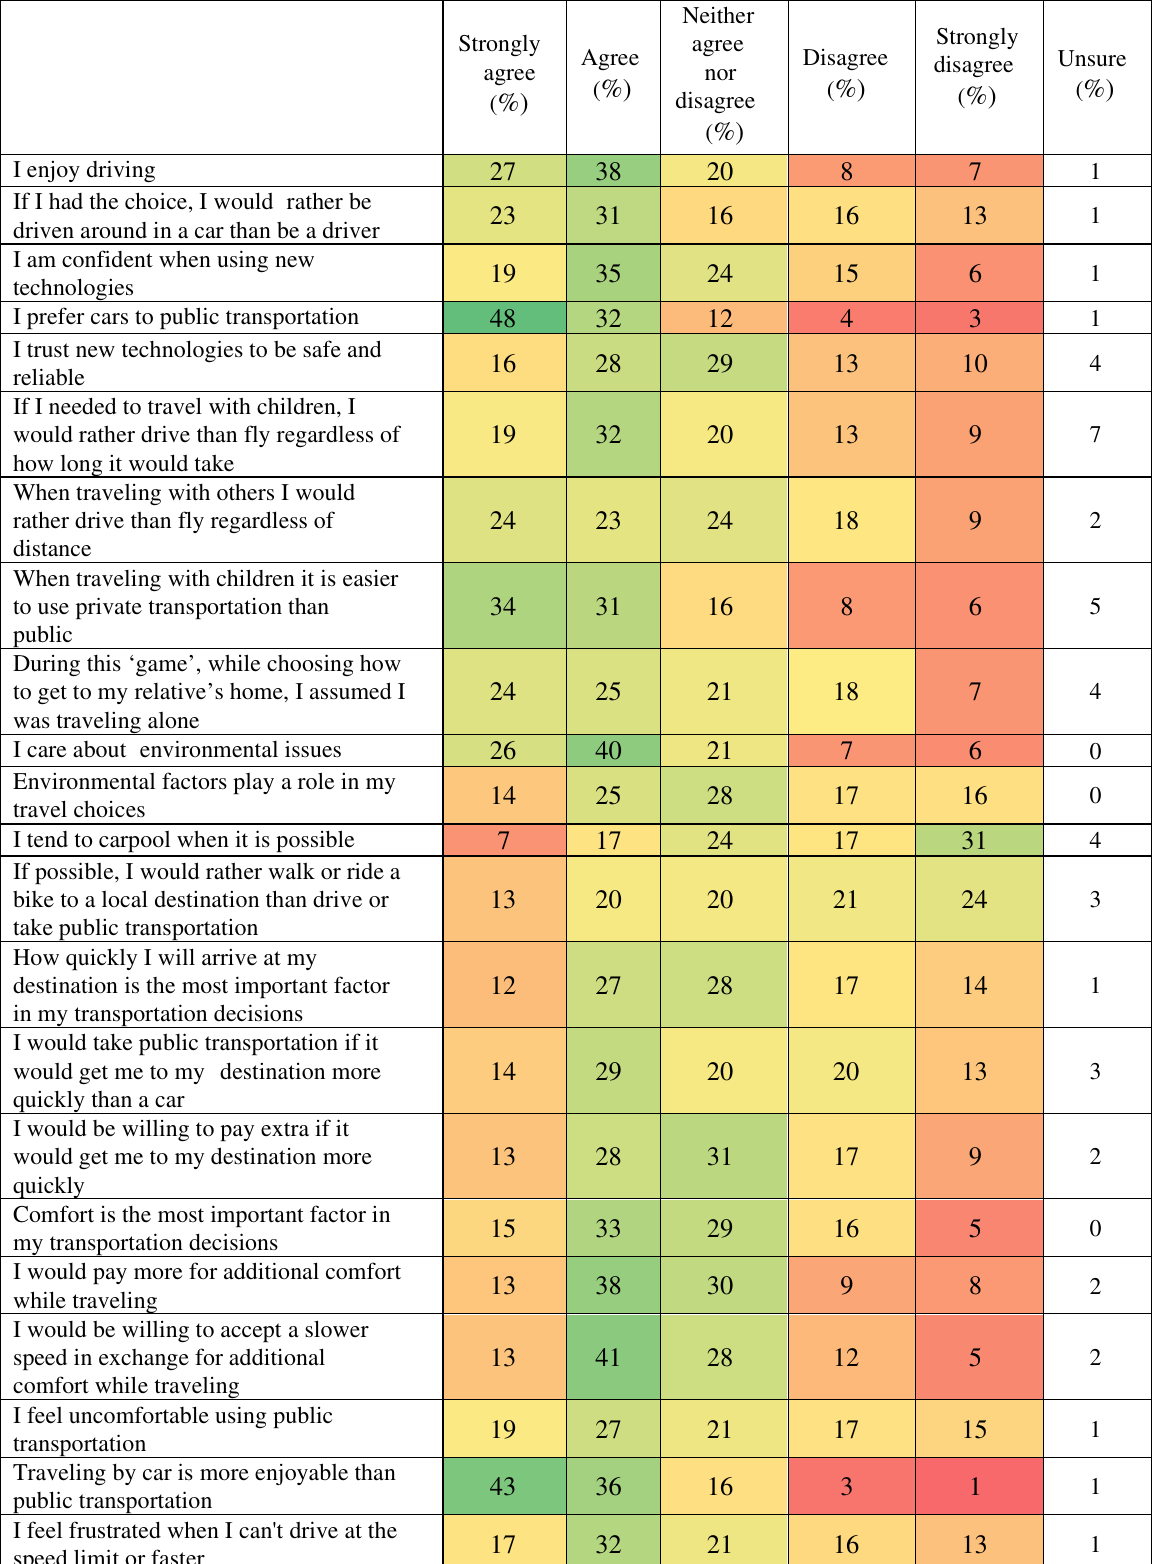
Table 4 Resposes to attitudinal